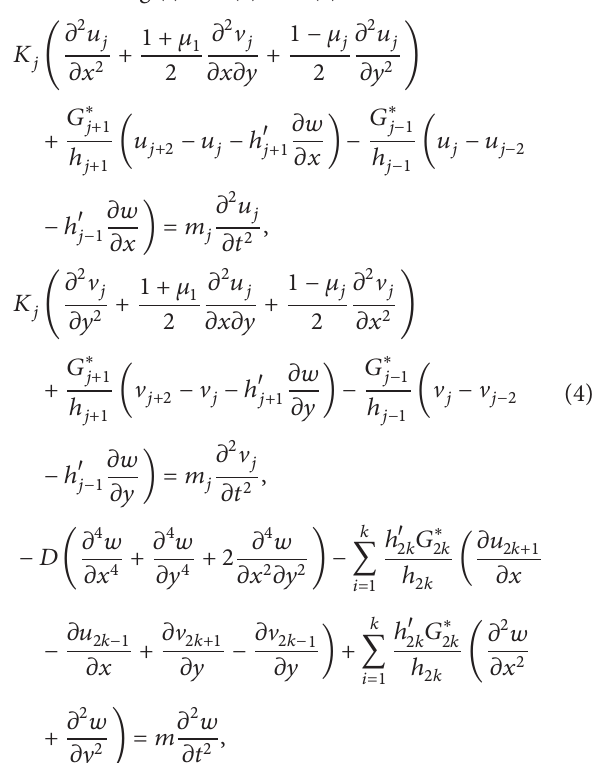
where there are 2𝑘 + 3 equations and 2𝑘 + 3 variables in